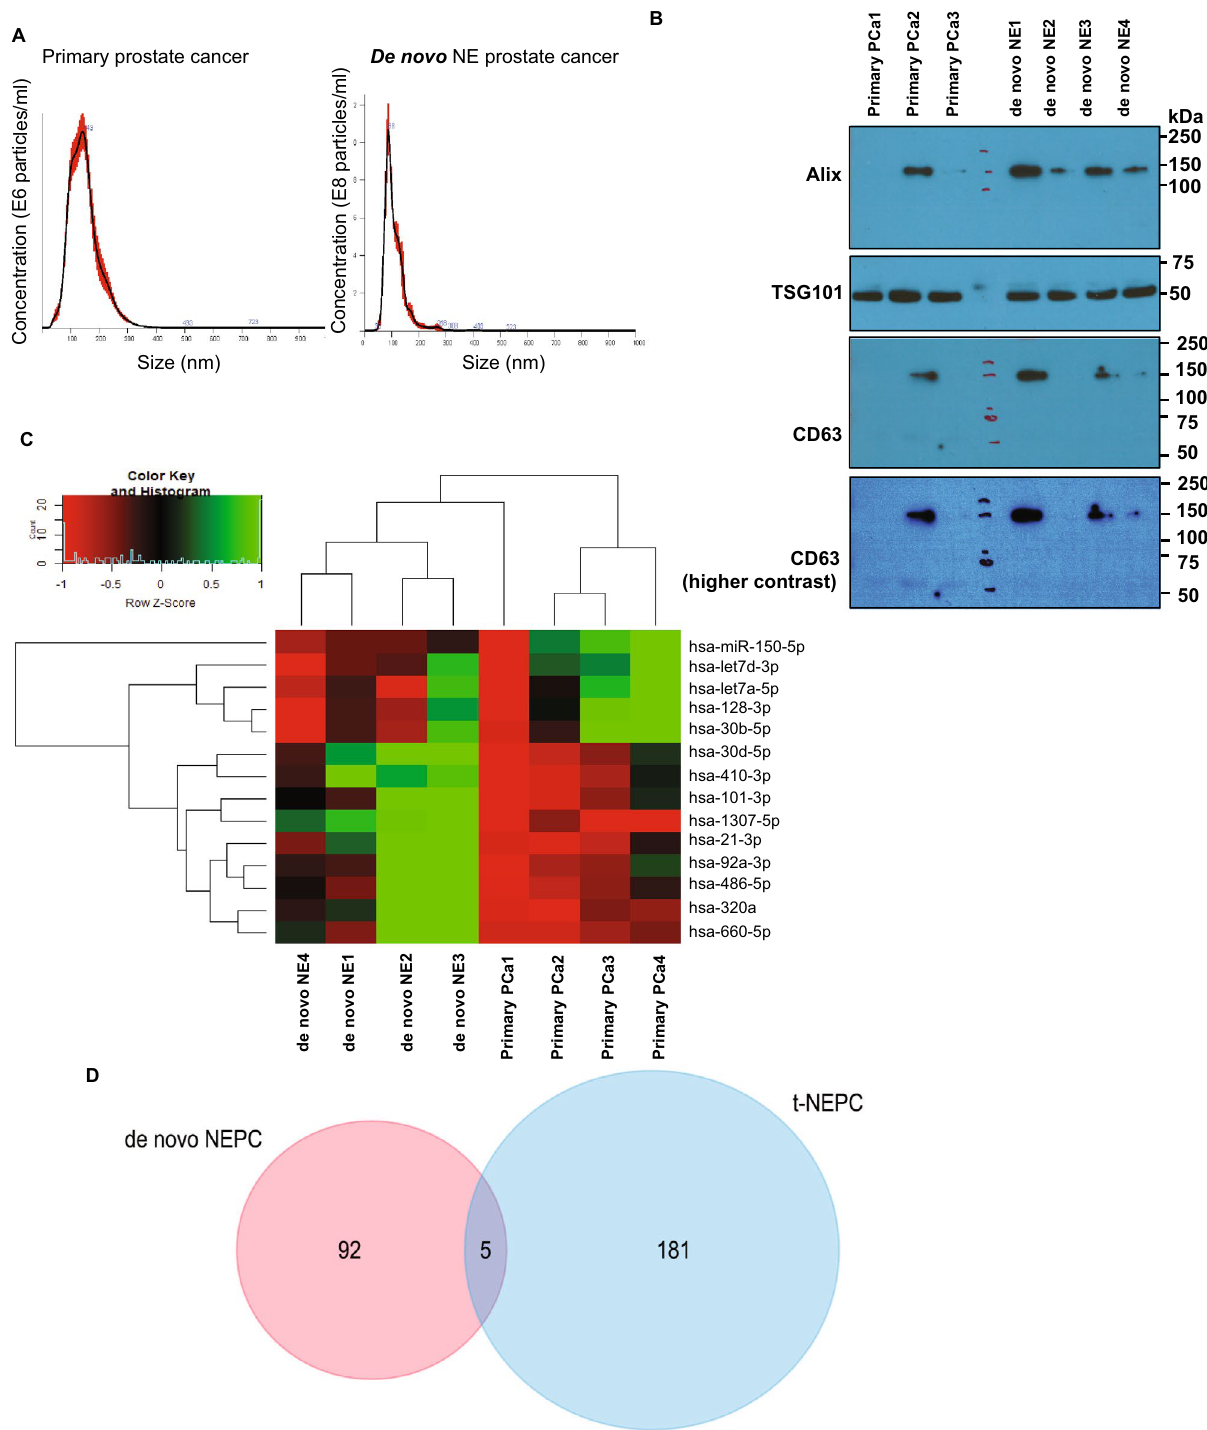
Figure 5. EV-miRNA profiling of de novo NEPC shows distinct miRNA alterations from treatment-induced NEPC. ( A ) Representative NTA analyses of EVs isolated from primary adenocarcinomas (left) and de novo NEPC (right). ( B ) Western blot analyses for exosomal markers in EVs isolated from primary adenocarcinomas and de novo NEPC. Following transfer of gel, blots were cut according to molecular weights. Upper parts of blots were probed with Alix antibody and lower parts were probed with TSG101 antibody. Since CD63 and TSG101 fall in same size range, following stripping, blots were re-probed with CD63 antibody. ( C ) Heat map showing differentially expressed miRNAs in EVs from de novo NEPC patients and those with primary adenocarcinomas. Heat map was generated by using R studio software, Version 1.1.463 (https:// www. npackd. org/p/ rstud io/1. 1. 463). ( D ) Venn diagram showing miRNA altered significantly in de novo NEPC vs treatment induced